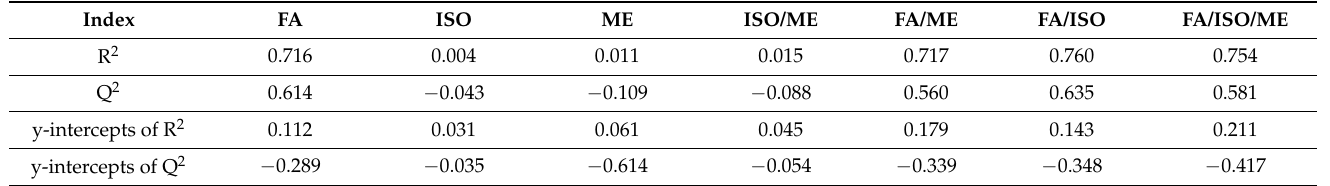
Table 2. Characteristics and evaluations of the OPLS-DA models for the inter-provincial milk